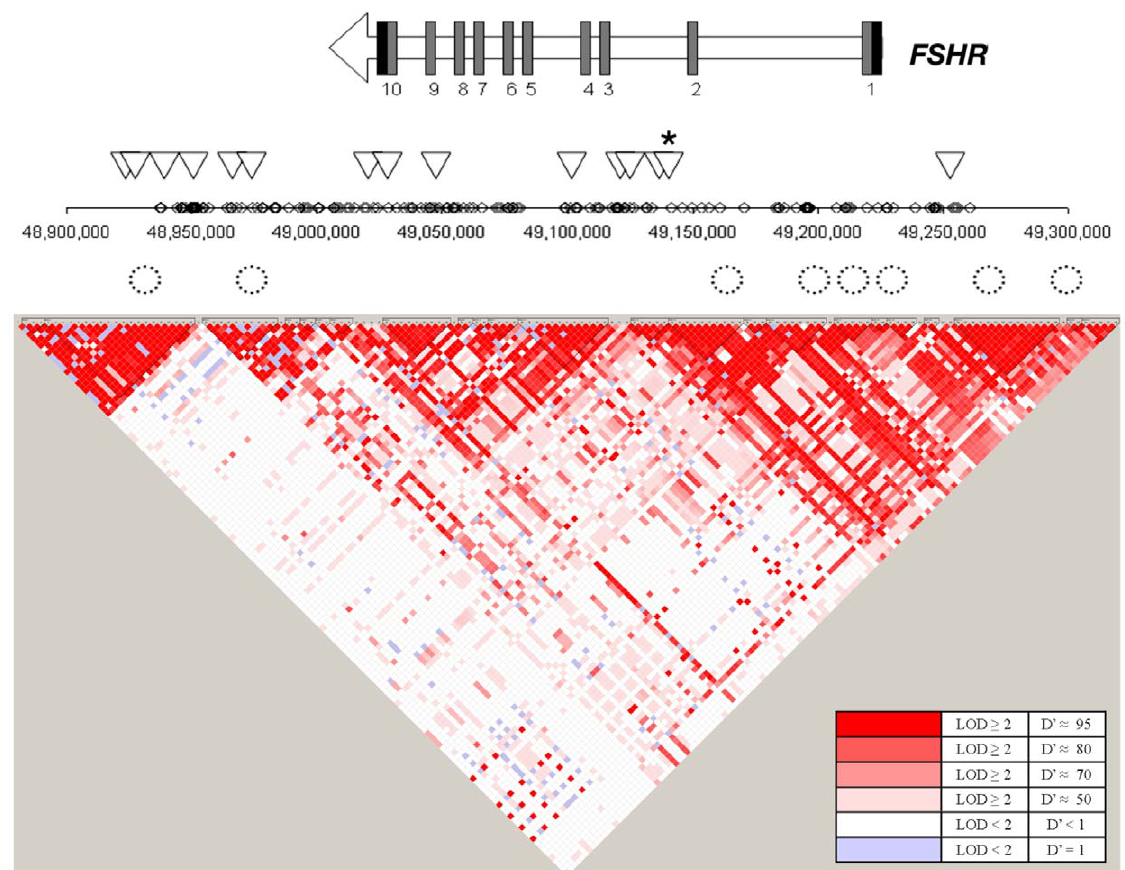
Figure 3. Overview of the SNPs tested in the FSHR gene region. The gene structure for FSHR is represented by an arrow in which black rectangles designate 3 9 and 5 9 untranslated regions and dark grey rectangles designate coding exons. Diamonds represent SNPs on the Affymetrix SNP 6.0 array examined in the Finnish cohort. Triangles represent SNPs tested in the replication cohorts. A star indicates rs12473815, and the LD block that includes rs11686474 and rs11680730, which is significant after multiple testing correction in African Americans (p # 0.005). Circles represent conserved elements examined in the region.